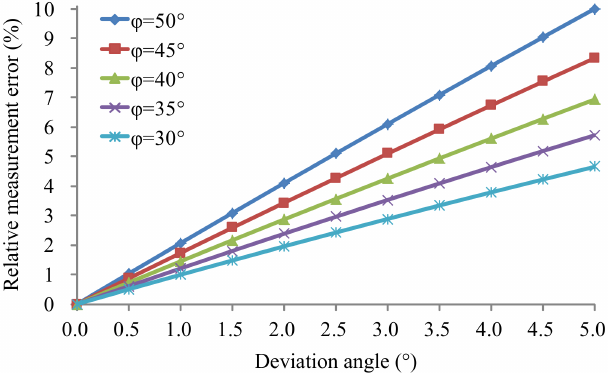
Figure 3. Relative measurement errors of the SDRS in the actual situation with different installation deviation